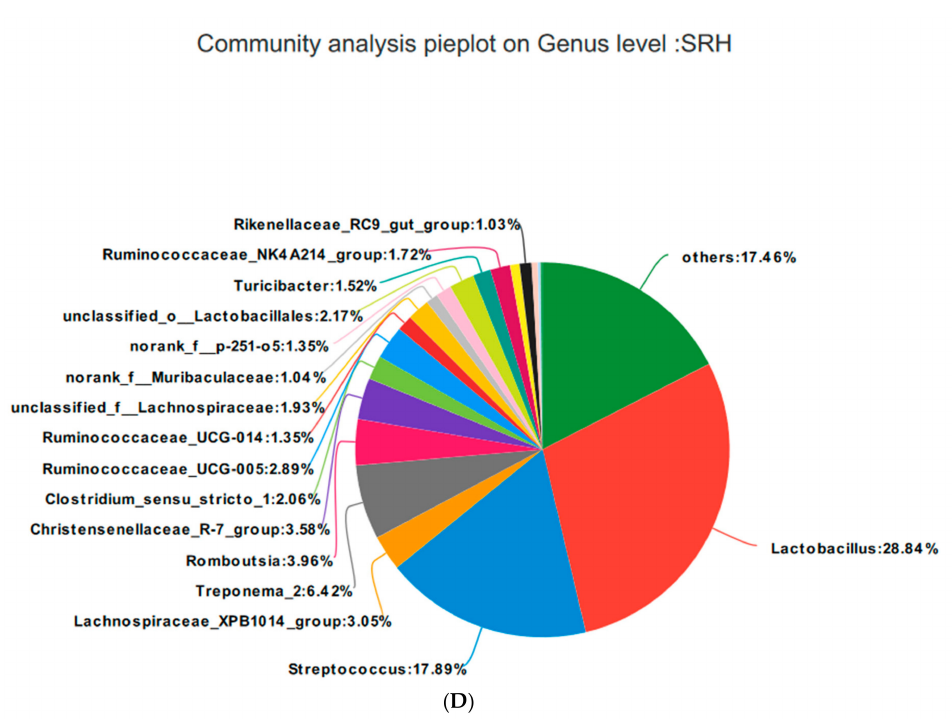
Figure 9. Fan chart of the relative genera abundance. The gut bacterial composition at the genus level in each sample. According to the results of the species notes, we selected the gut bacterial species at the genus level in CON ( A ), SRL ( B ), SRM ( C ), and SRH ( D ). Relative abundances < 0.01% were classified as others.